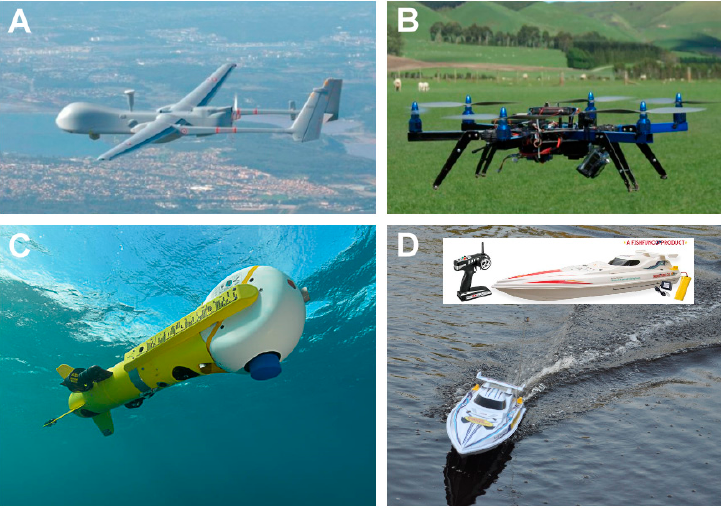
Figure 22. UAV, AUV, and ROV. ( A ) UAV (http://www.evolvsys.cz/news/news_2006.html); ( B ) drone to measure crop properties (http://www.dronemagazine.it); ( C ) AUV to detect and dispose underwater mines (http://www.ecagroup.com); ( D ) hobby boat that could be used to carry instrumentation to measure VOCs (Radio Ranger Fishing Boat, http://www.rcfishingworld.com/).